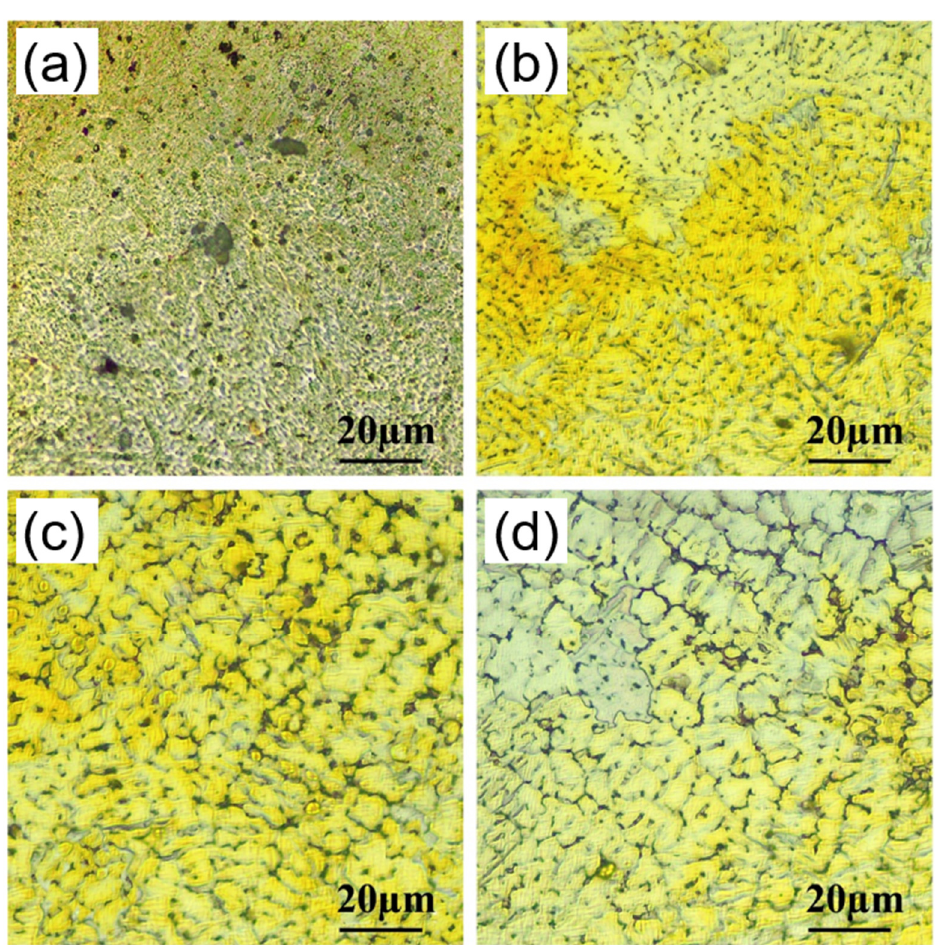
Figure 9. Microstructures of SLM ZK60 samples at different parameters, ( a ) 420 J/mm 3 ; ( b ) 500 J/mm 3 ; ( c ) 600 J/mm 3 ; ( d ) 750 J/mm 3 . Reprinted with permission from ref. [59]. Copyright 2017 Else- vier.